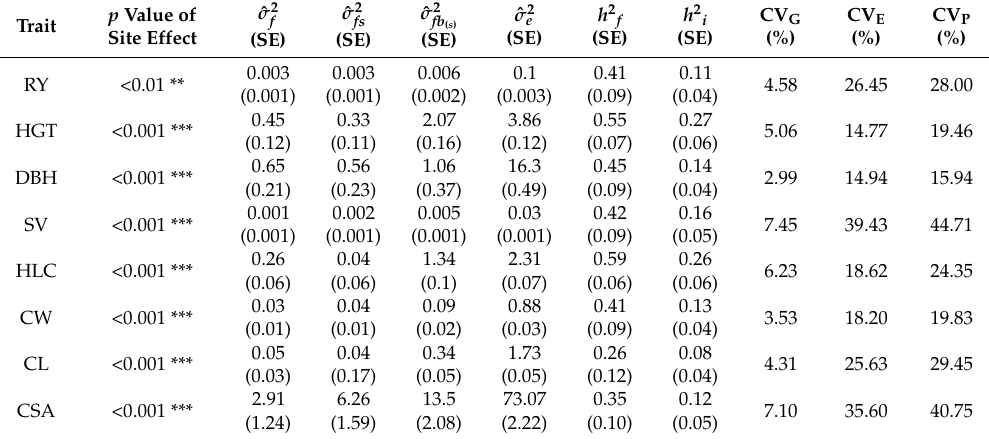
Table 3. Estimates of variances (ˆ σ 2 interactions and residual variances, respectively, family mean and individual narrow sense heritability (ˆ h 2 , ˆ h 2 ) (with standard error in parenthesis), and coefficient of variation at genetic, phenotypic and i f residual level (CV G , CV P and CV E ) for various traits from site combined